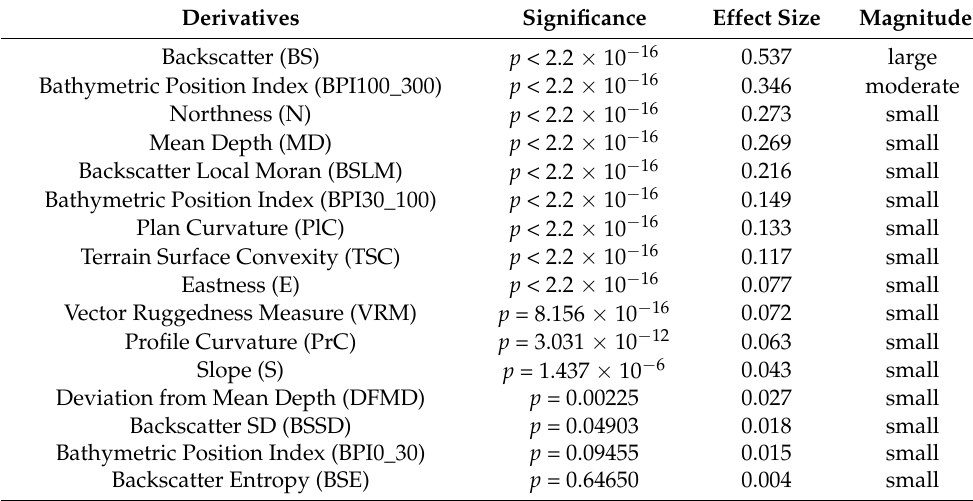
Table 2. Wilcoxon–Mann–Whitney test results between statistically significant spatial clusters and MBES derivatives. The statistical significance ( p -value) is given together with the substantive significance (effect size) for the interpretation of the results when the p -values are the same or similar. Its calculation and magnitude classification were based on [115].